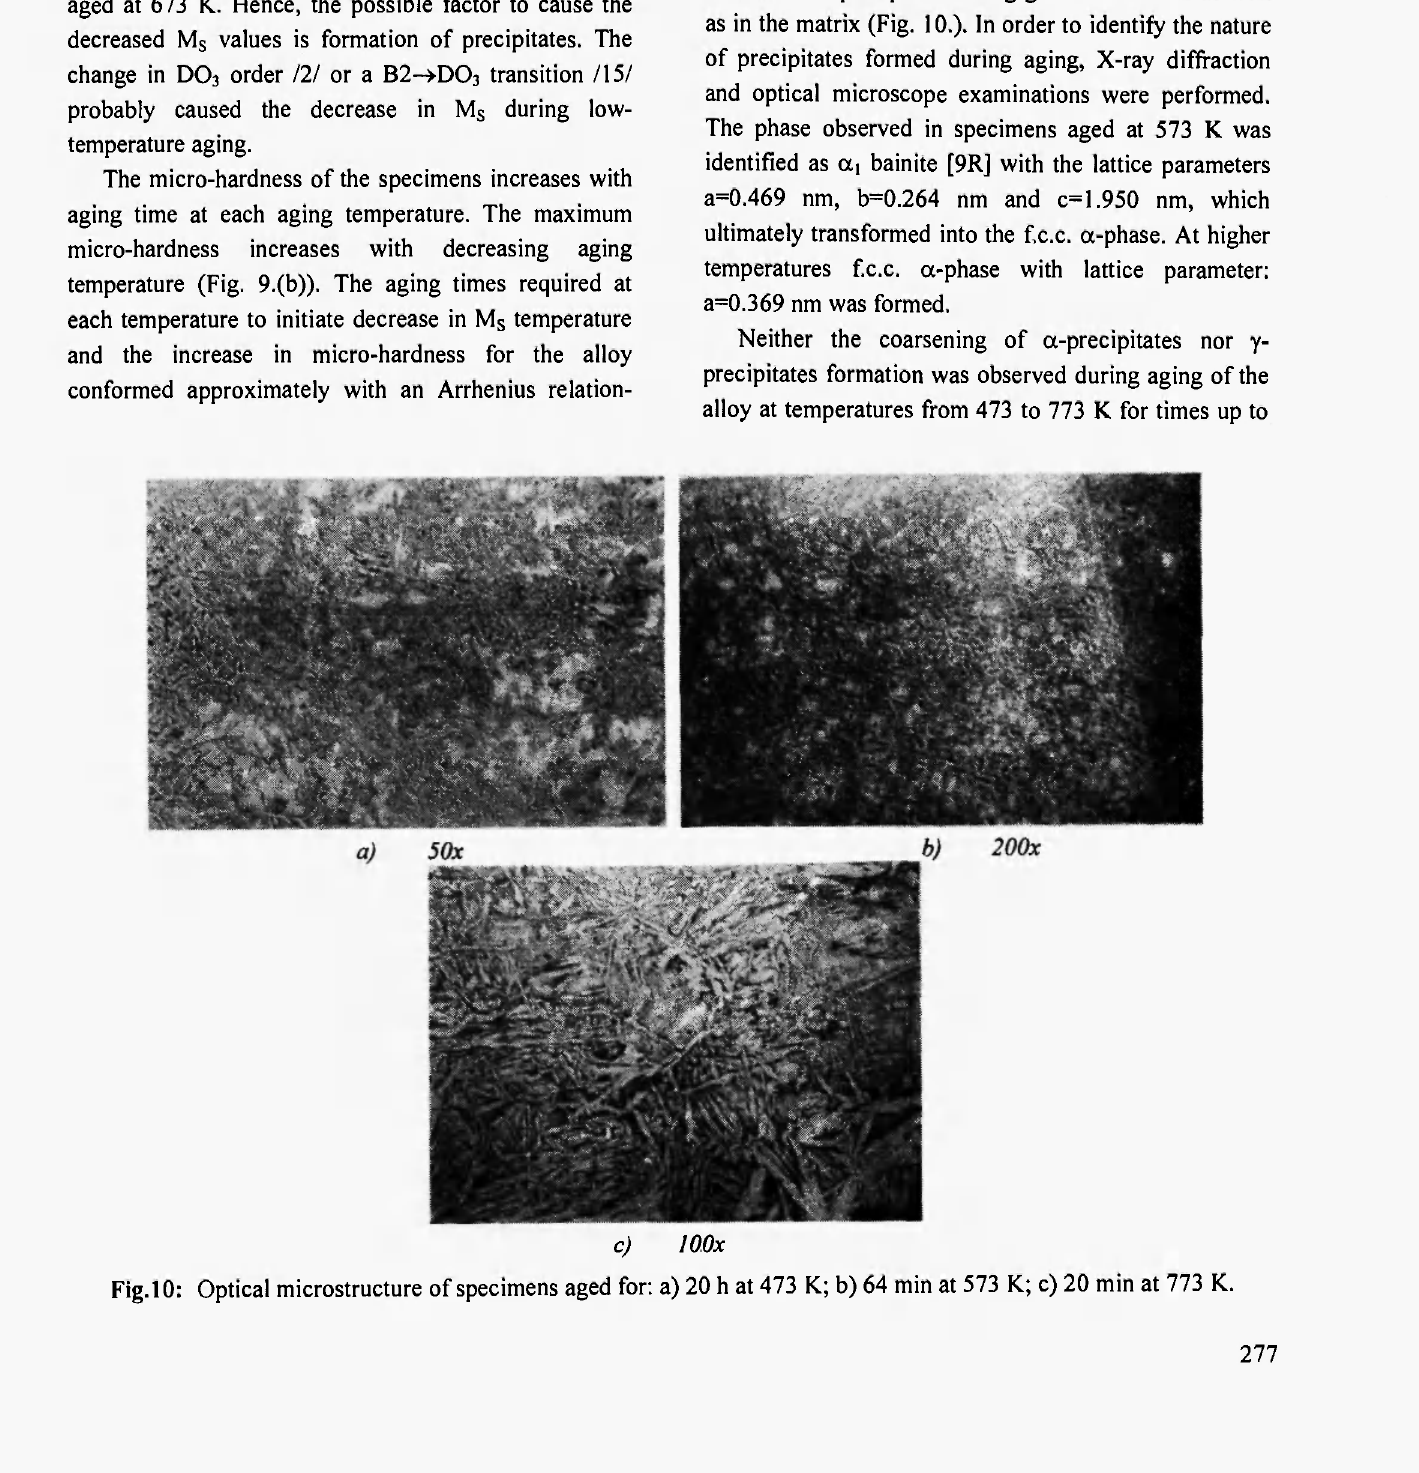
Fig. 10: Optical microstructure of specimens aged for: a) 20 h at 473 K; b) 64 min at 573 K; c) 20 min at 773